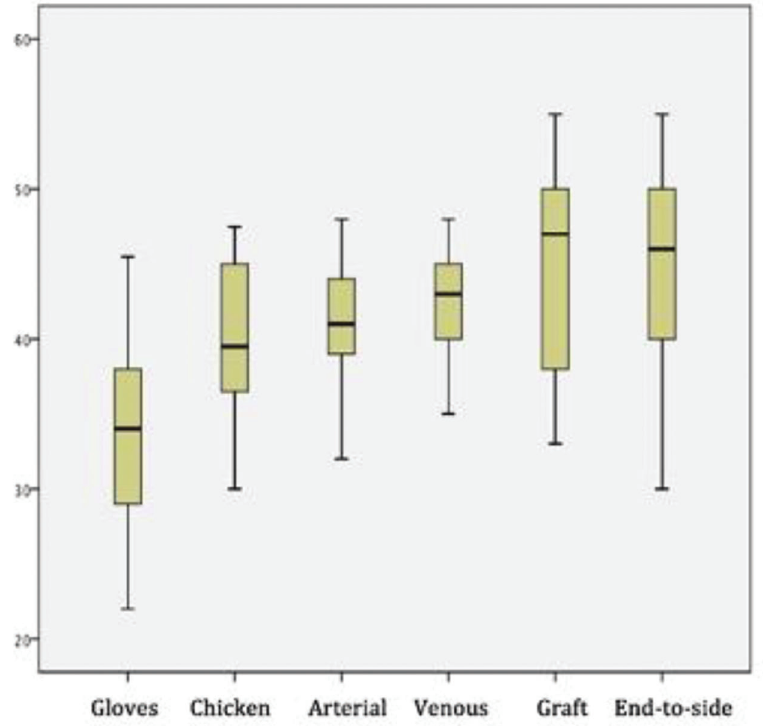
Figure 4 - Scores in different skills. The box plots show pooled scores of different skills ( p o